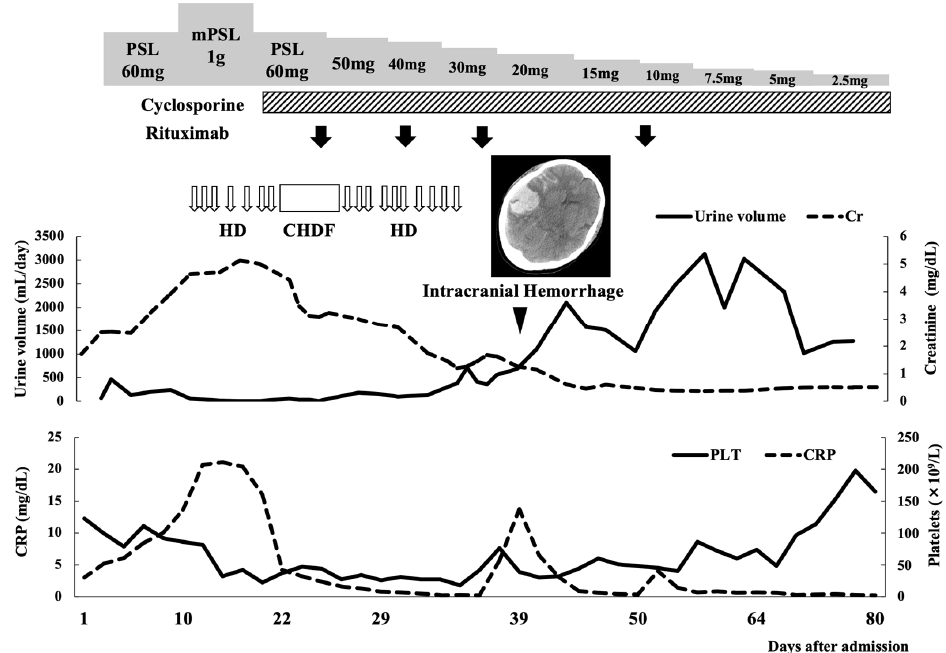
Figure 4. Clinical course of the patient after transfer to our hospital. Cranial computed tomography imaging of the patient shows a life-threating hemorrhage in the right subarachnoid space and cerebral hemisphere. CHDF, continuous hemodiafiltration; Cr, creatinine; CRP, C-reactive protein; HD, hemodialysis; PLT, platelets; PSL, prednisolone.